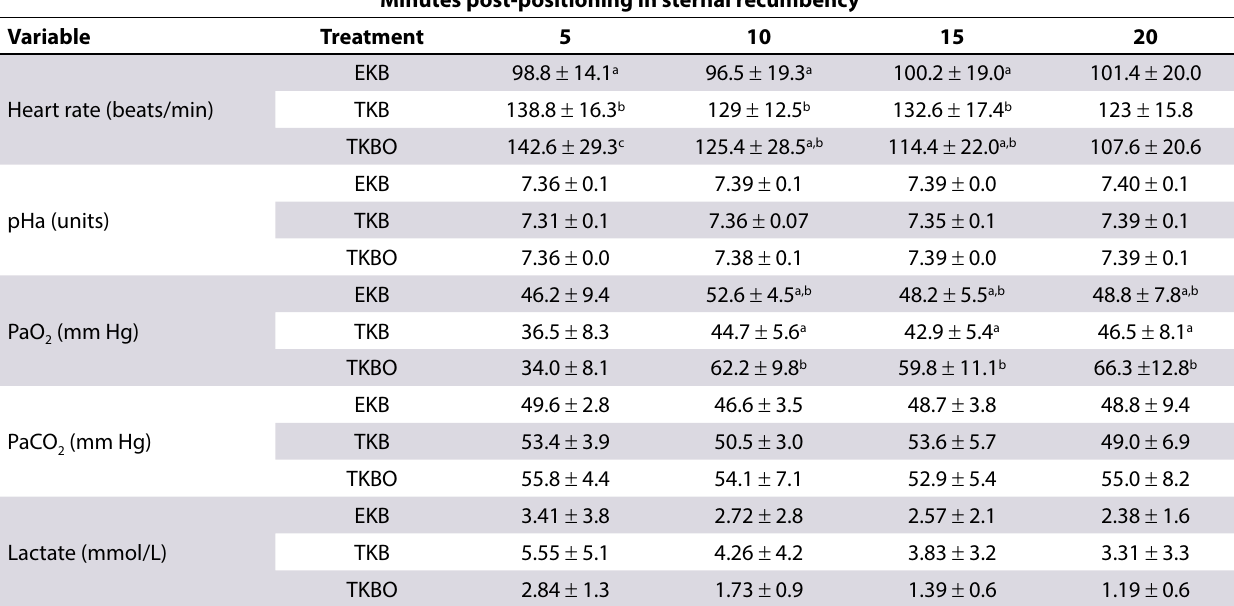
Table IV: Heart rate, pHa, PaO , and lactate values in black-faced impala ( Aepyceros melampus ssp. petersi ) administered 2.0 mg etorphine, 50 mg 2 ketamine, and 10 mg butorphanol, (treatment EKB) or 2.0 mg thiafentanil, 50 mg ketamine, and 10 mg butorphanol (treatment TKB) or 2.0 mg thiafentanil, 50 mg ketamine, and 10 mg butorphanol with supplemental oxygen (treatment